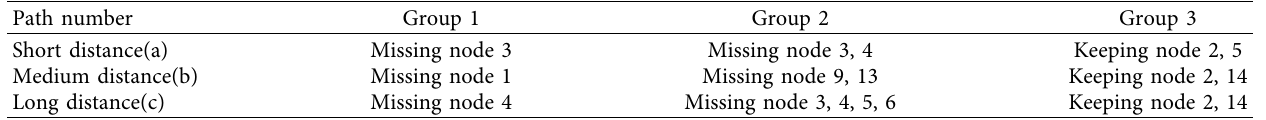
Table 7: Experimental design table.